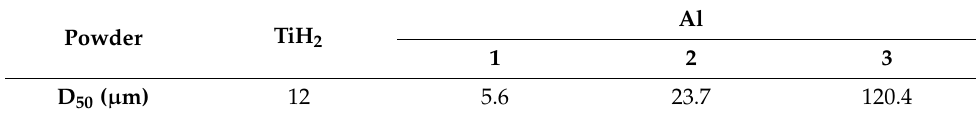
Table 1. Particle size of the raw material